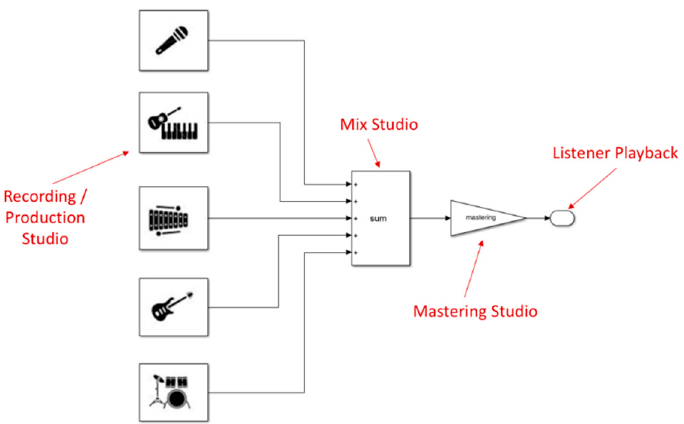
Figure 11. Conventional stereo mastering approach.